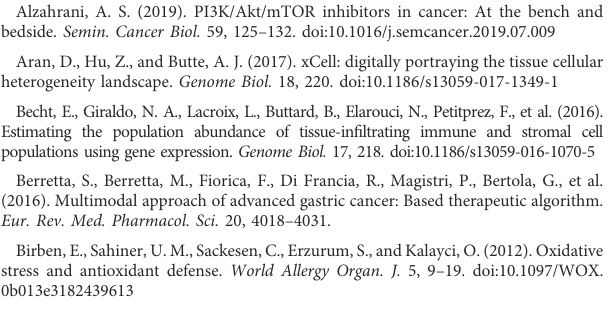
SUPPLEMENTARY FIGURE S1 The fl owchart of the analysis. SUPPLEMENTARY FIGURE S2 The PFS analysis between C1 and C2 clusters. SUPPLEMENTARY FIGURE S3 The K-M survival analysis between low- and high-risk GC. SUPPLEMENTARY FIGURE S4 The comparation analysis between ROS-related signature and other three models. SUPPLEMENTARY FIGURE S5 The mutation pro fi le of low- and high-risk